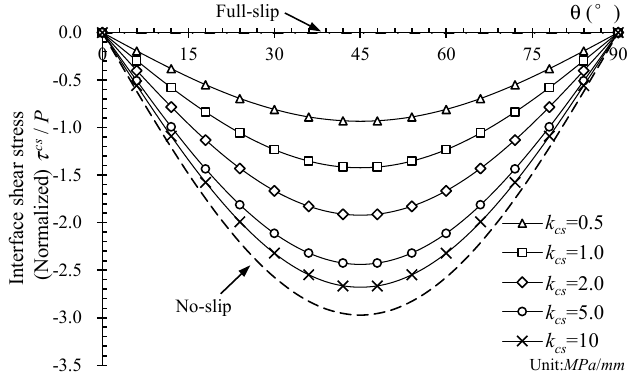
Figure 15. Influence of k cs on the interface shear stress.